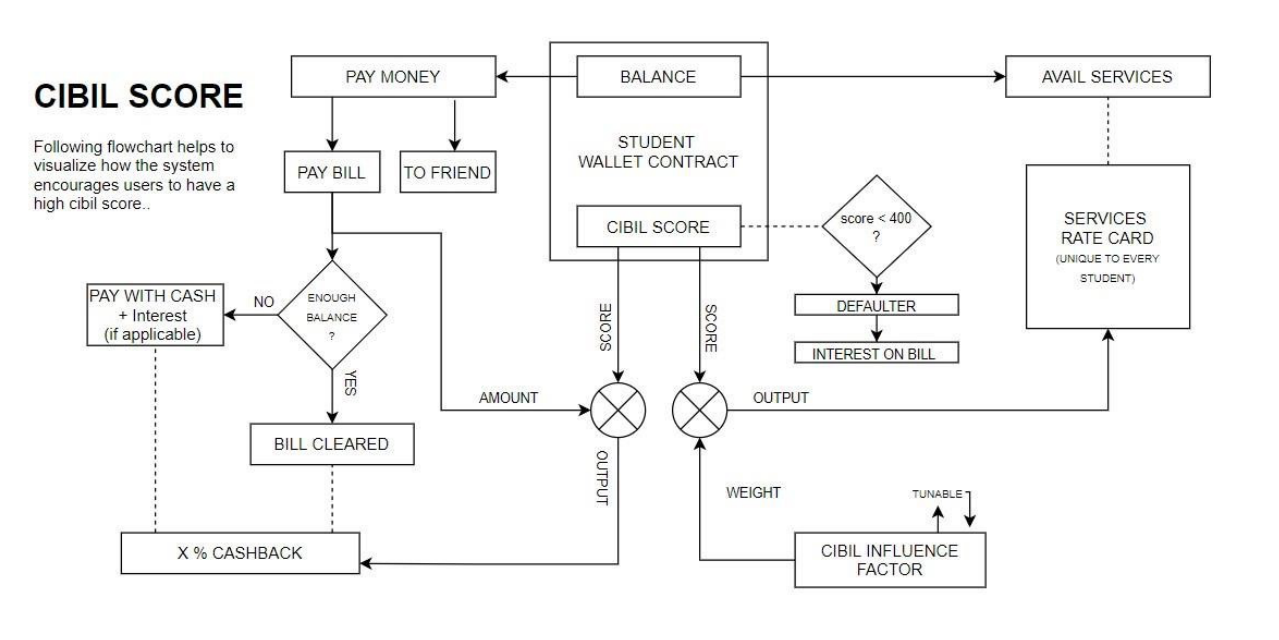
Figure 4. Overview of Cibil score’s